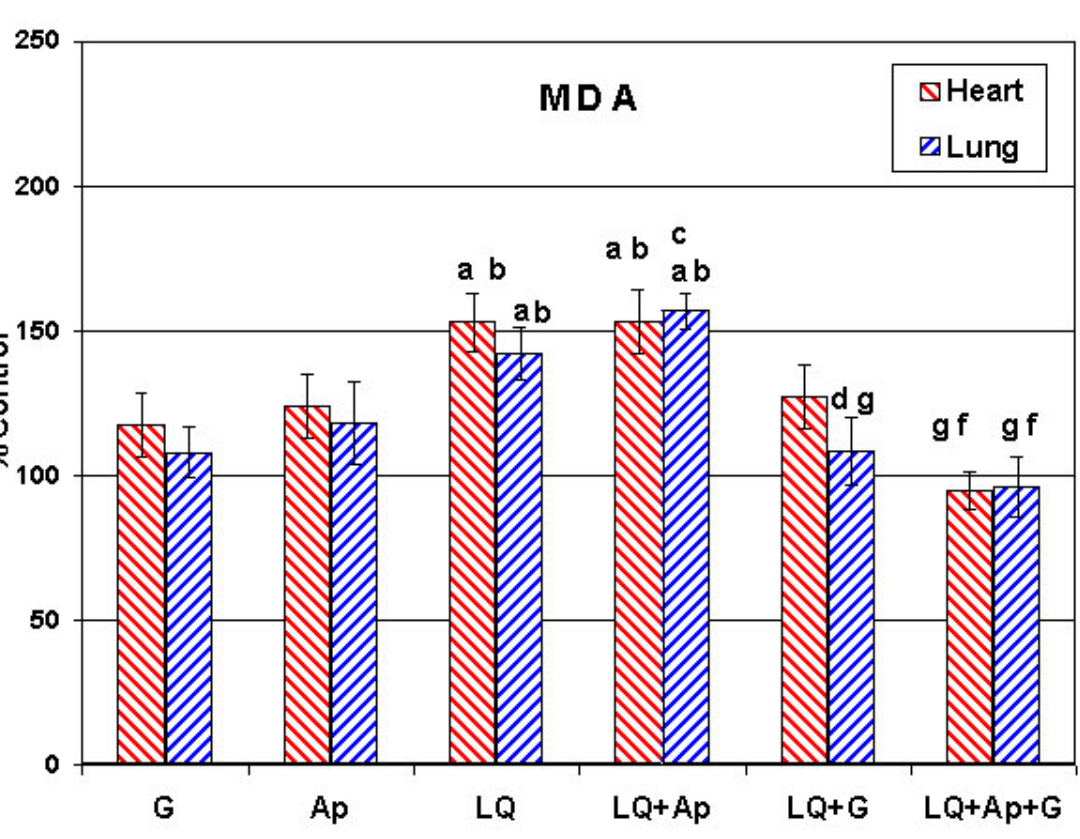
Figure 2: Effects of Leiurus quinquestriatus venom (LQ) alone or after pretreatment with Ginkgo biloba extract (G) and/or aprotinin (Ap) on malondialdehyde levels (MDA) in rat heart and lung